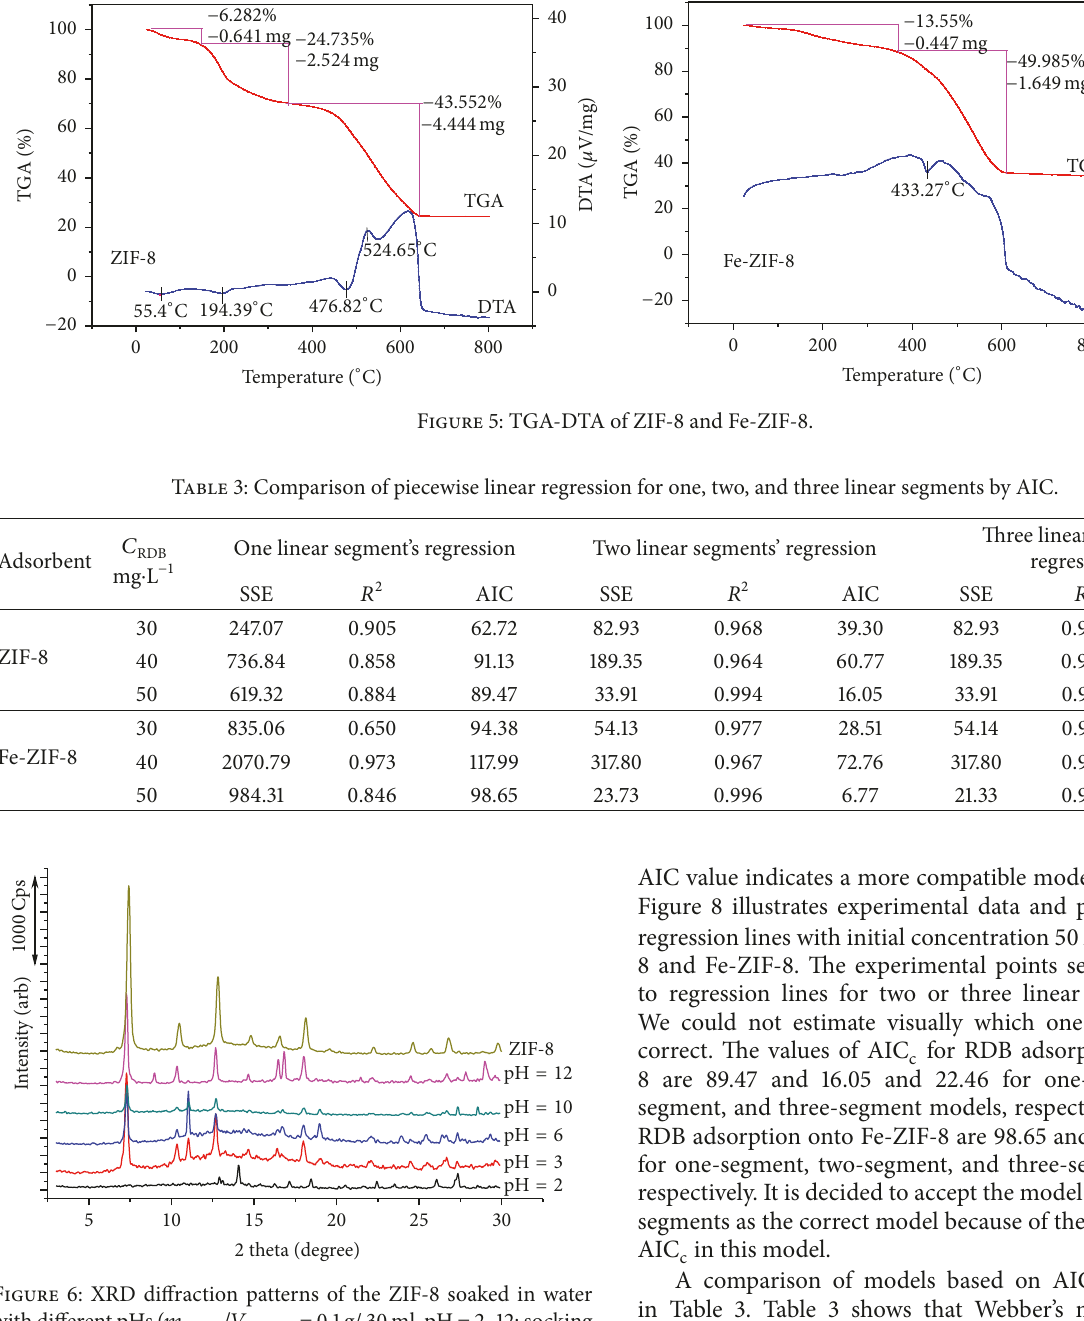
Table 4. For illustration, for 50 mg L −1 concentration of